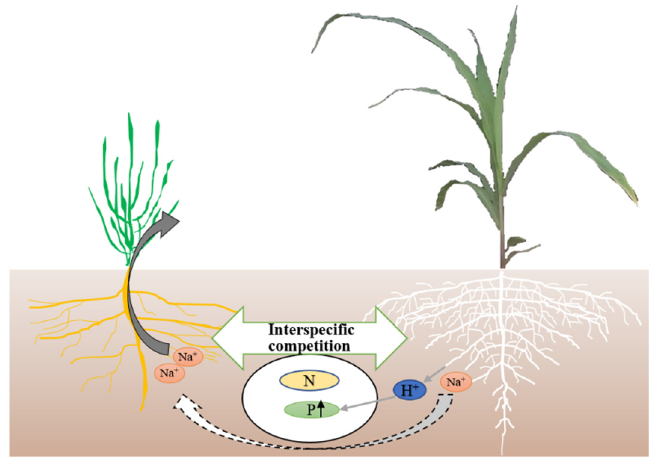
Figure 7. The potential mechanism in the suaeda/maize intercropping systems. Maize’s excretion decreases soil pH to activate more Olsen-P, but it facilitates the Na + shift to the suaeda root zone and interspecific competition for nutrients.